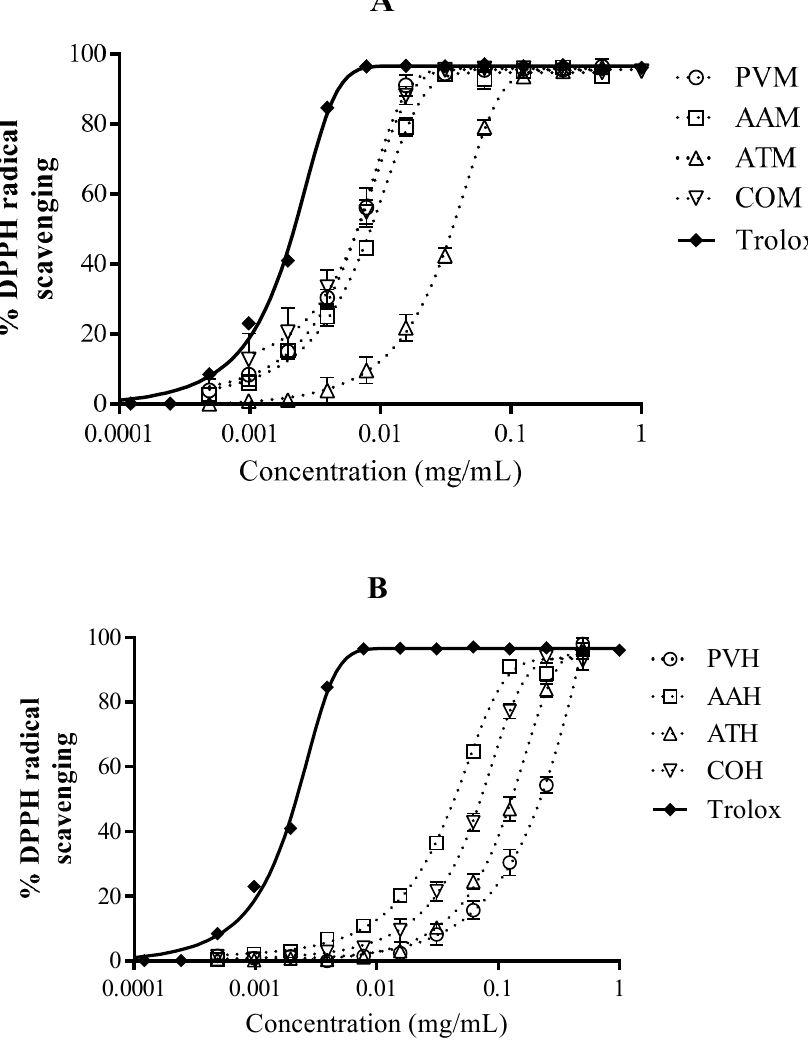
Figure 1. Antioxidant activity against DPPH radicals of methanol extracts ( A ) and hexane extracts ( B ) using trolox as a reference.